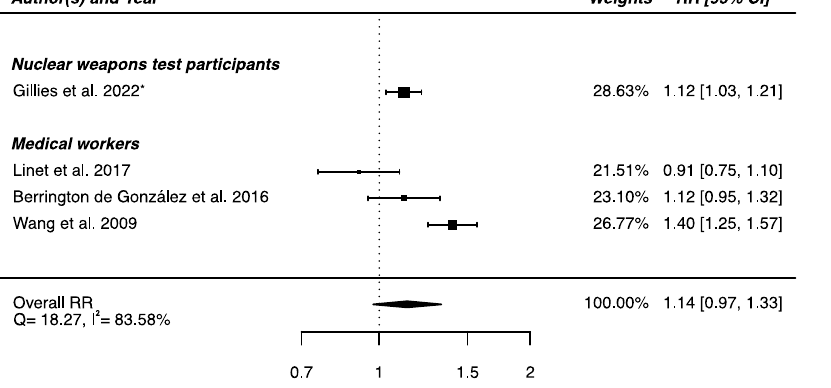
Figure 7. Relative risk (RR) and 95% confidence interval (CI) for mortality from cerebrovascular diseases in the reviewed studies among IR exposed populations compared with unexposed controls. * 90% CI.